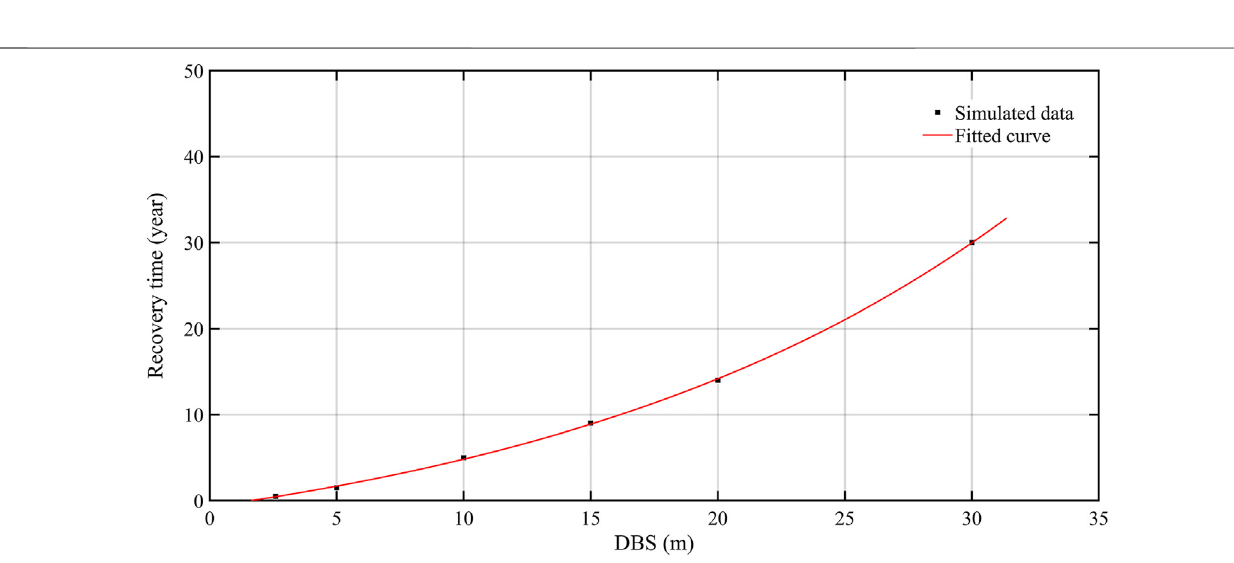
Frontiers in Earth Science |